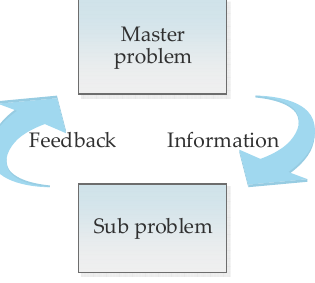
Figure 8. Schematic representation of Benders decomposition method.